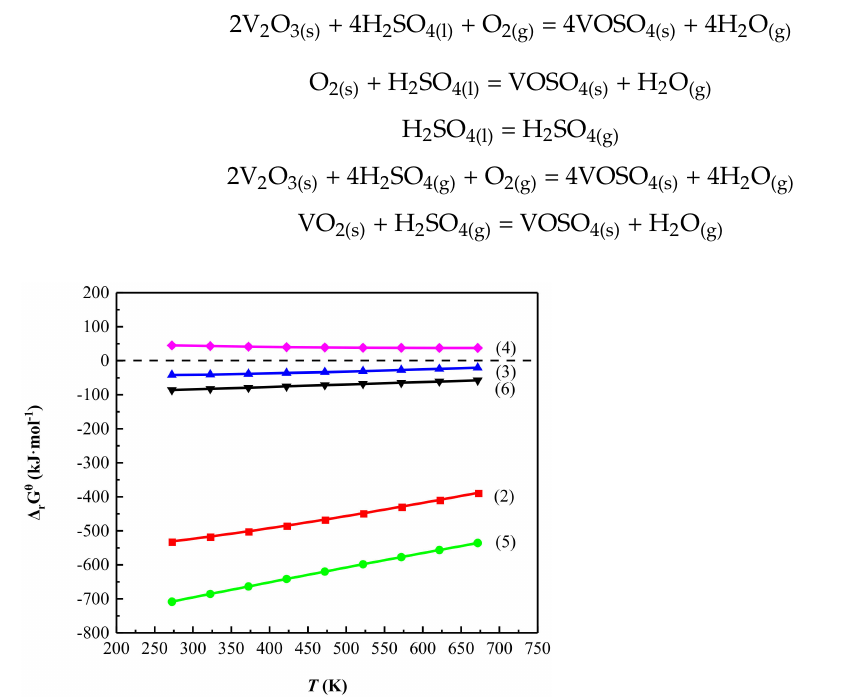
Figure 2. Correlation of standard Gibbs free energy ( ∆ r G θ ) with temperature for the reactions in Equations